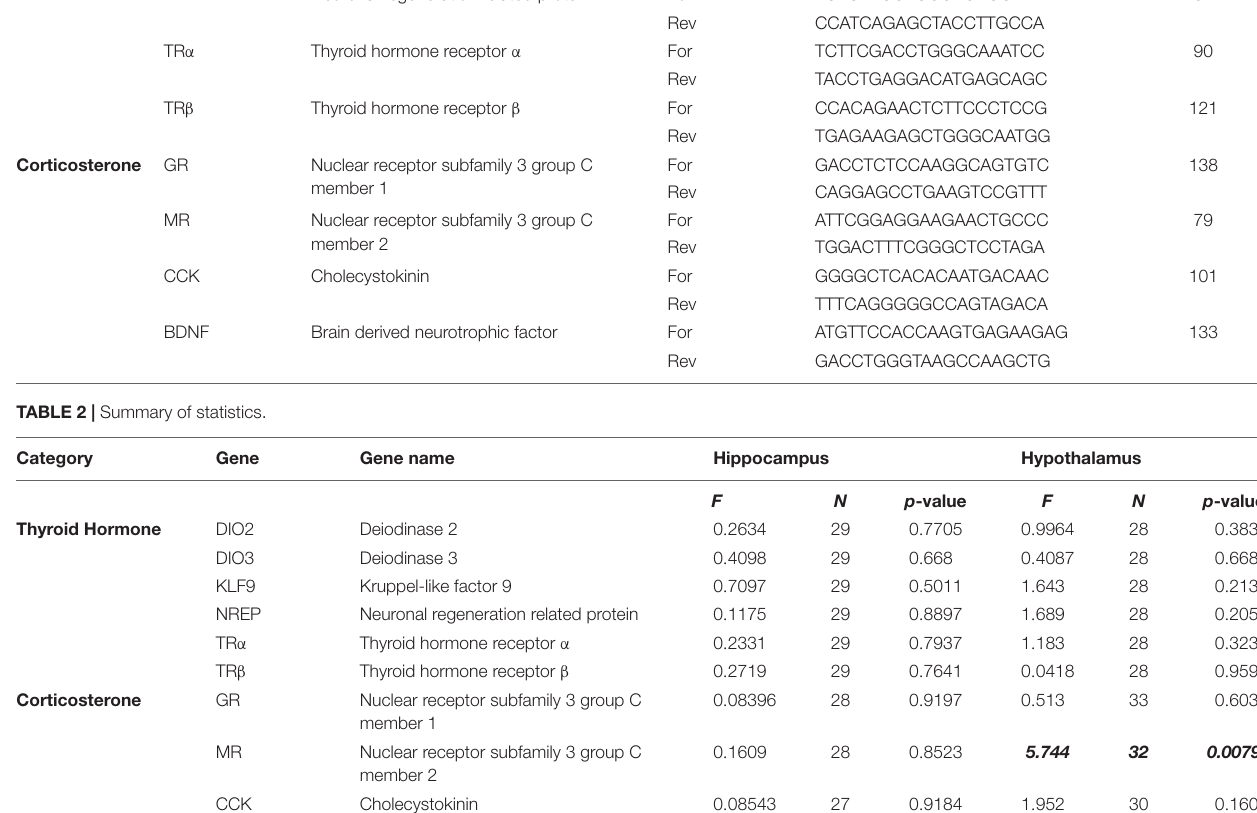
KLF9 ( Figure 1C ) and the receptors of thyroid hormone, TR α , and TR β ( Figures 1E,F ) in 0 day-old ducklings. We also found that BDNF expression was much higher in the hippocampus than in the hypothalamus in 15 day-old ducklings ( Figure 2D ). We found that MR mRNA expression was significantly higher in the right hemisphere compared to the left hemisphere ( p = 0.015) of the hypothalamus, but there were no other hemispheric differences in other genes/brain regions (all p ≥